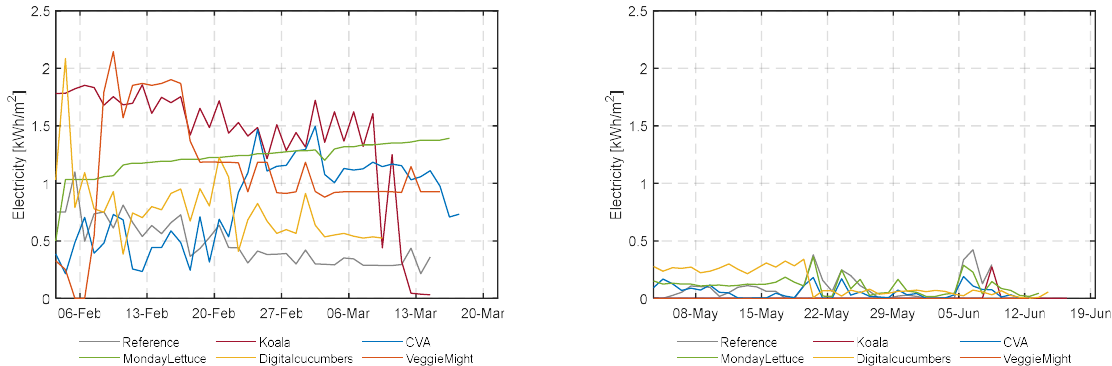
Figure A4. Artificial lighting usage in all compartments during the first and second cultivation.